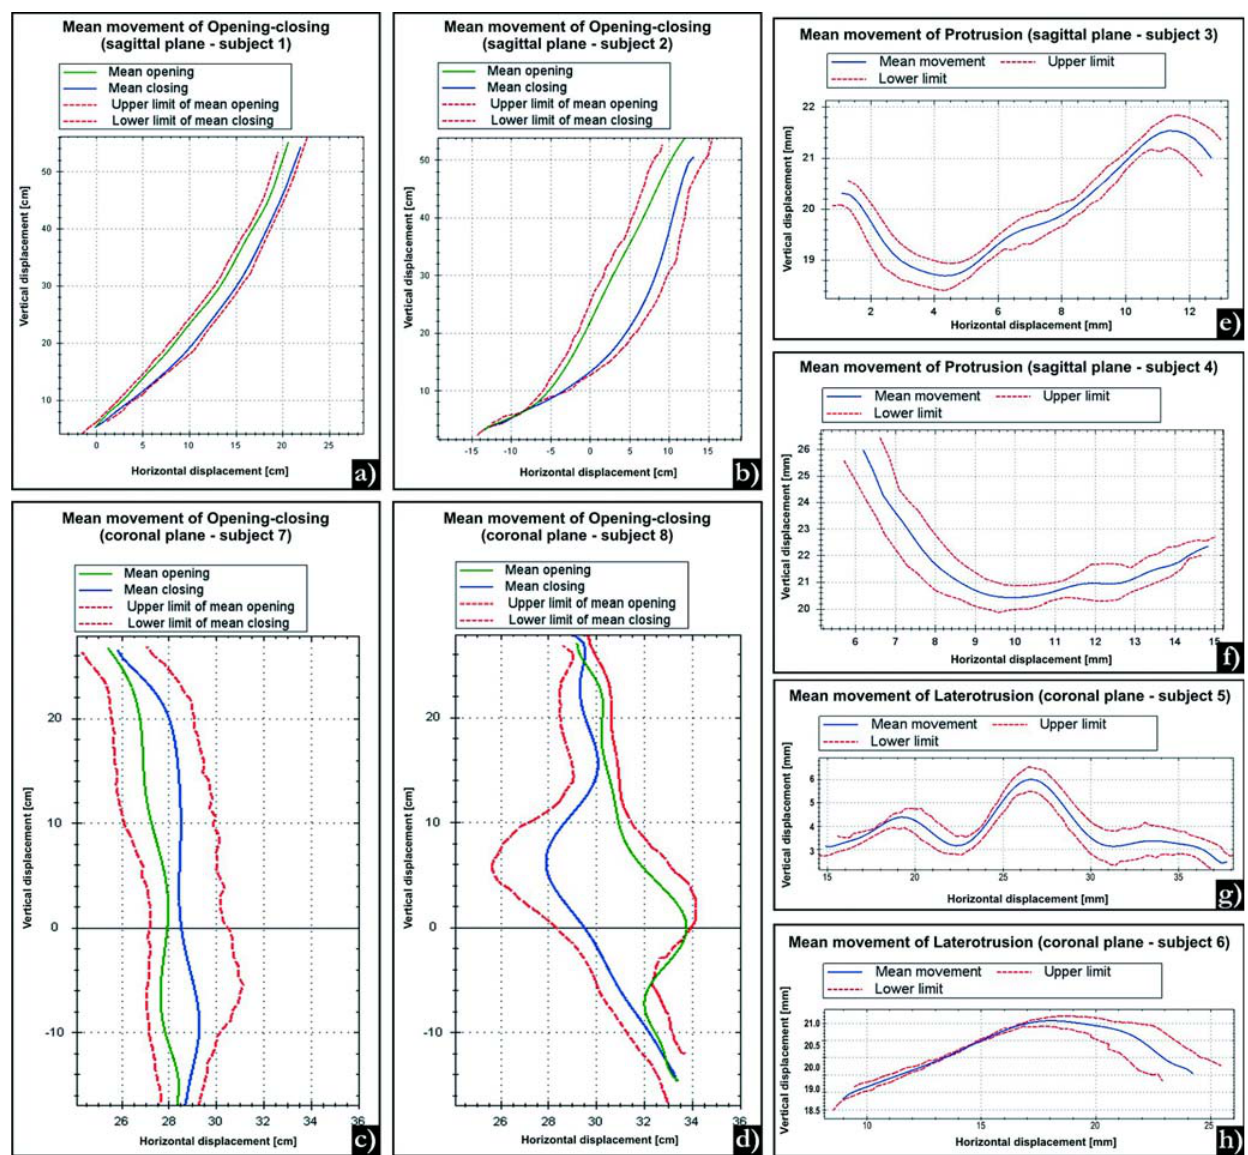
FIGURE 4- Graphs showing the evaluation of the functional movements of the mandible from 8 subjects. (a) Normal opening-closing movement (sagittal plane). (b) Opening-closing movement of a subject with disc displacement of TMJ (sagittal plane). (c) Normal opening-closing movement (coronal plane). (d) Opening-closing movement of a subject with disc displacement of TMJ (coronal plane). (e) Normal lateral protrusion movement. (f) Lateral protrusion movement from a subject with a deep bite. (g) Normal laterotrusion movement. (h) Laterotrusion from a subject with a right-sided chewing